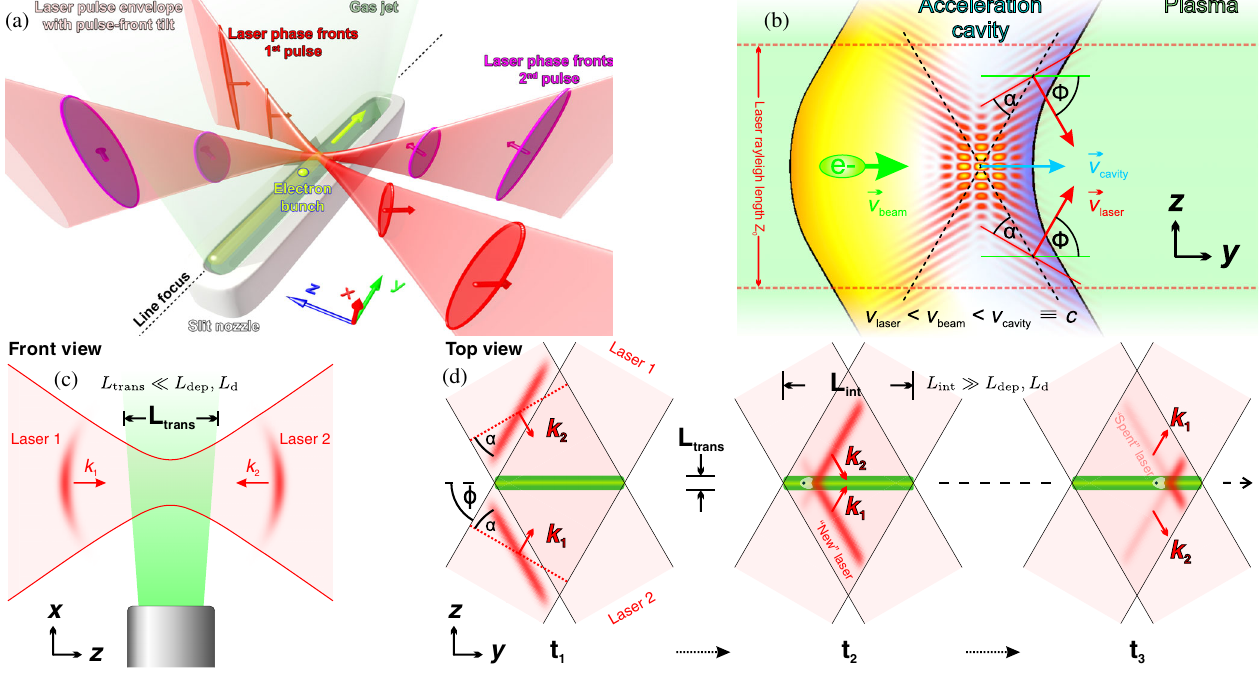
FIG. 1. TWEAC features a laser-plasma interaction region, which propagates with exactly the speed of light, thus remaining synchronized to the accelerated electron bunch arbitrarily far beyond the dephasing length — limited by the spatial extent of the laser pulse only. (a) Illustration of the required geometry of two ultrashort, pulse-front-tilted, obliquely incident laser beams in a line focus, driving a wakefield in a slit-nozzle generated gas jet for accelerating an electron bunch. Surfaces of equal phase within each laser beam mark the direction of pulse propagation (here, 60° with respect to the main axis) relative to the pulse-front tilt. (b) Zoomed-in schematic of the accelerating region. The two TWEAC lasers (red intensity contours) drive a copropagating V-shaped plasma cavity with ≡ c that accelerates an electron bunch in its longitudinal cavity field (orange-white-purple). (c) Cylindrical v < v < v laser beam cavity focusing geometry. (d) Illustration of the comoving laser overlap, as well as the laser field cycling through the laser-plasma interaction